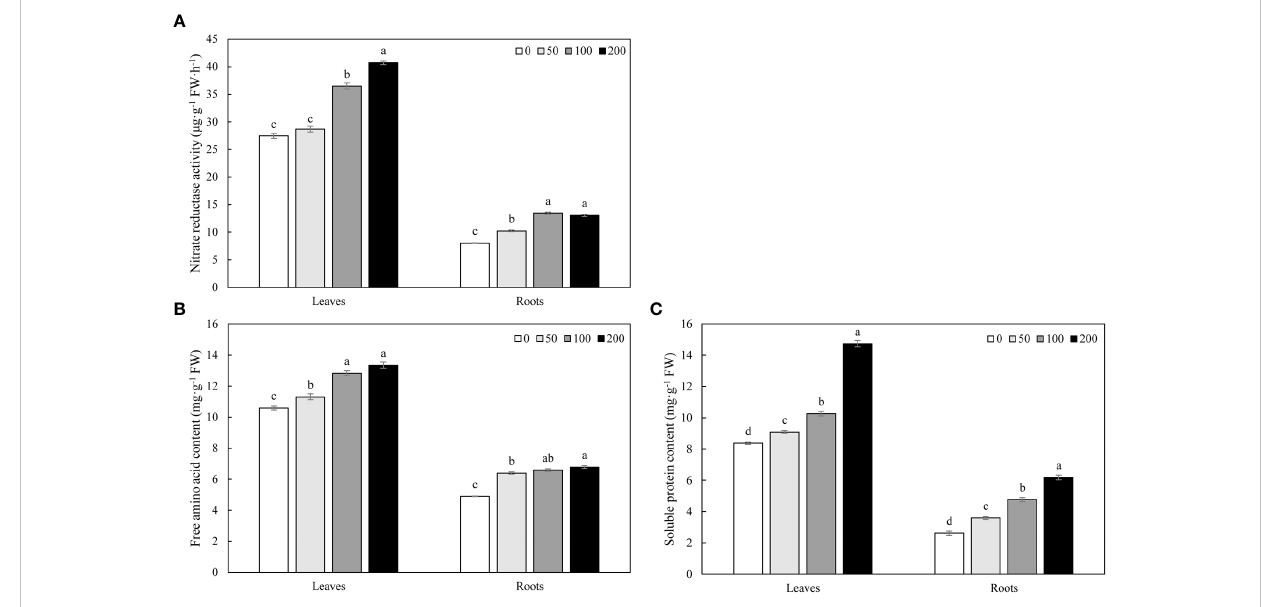
FIGURE 4 NR activity (A) , free amino acid (B) , and soluble protein content (C) in roots and leaves of Malus hupehensis seedlings under the 0, 50, 100, and 200 µg·mL -1 MWCNTs treatments for 30 days. Different lowercase letters indicate signi fi cant difference at P < 0.05, and error bars represent the standard deviation of the mean (One-way ANOVA, n=6).